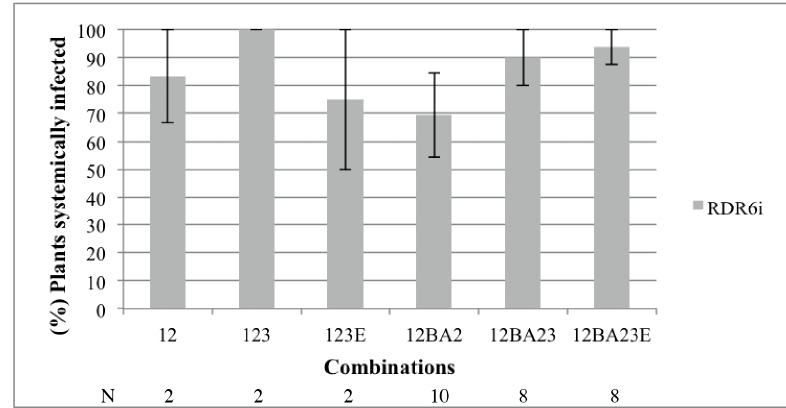
Figure 4. Systemic movement of BNYVV expressing BA2 p14 mutant is restored by a RNA-dependent RNA polymerase 6 knockdown (RDR6i). RDR6i Nicotiana benthamiana were infected with RNA1 + 2 (12) or RNA1 + 2BA2 (12BA2) supplemented or not with RNA3 (123, 12BA23) or RNA3E (123E, 12BA23E). Viral RNA detection on upper leaves was performed at 21 dpi. Three independent experiments using specified numbers (N) of plants were performed, and statistical analyses were carried out using Fisher’s exact test.